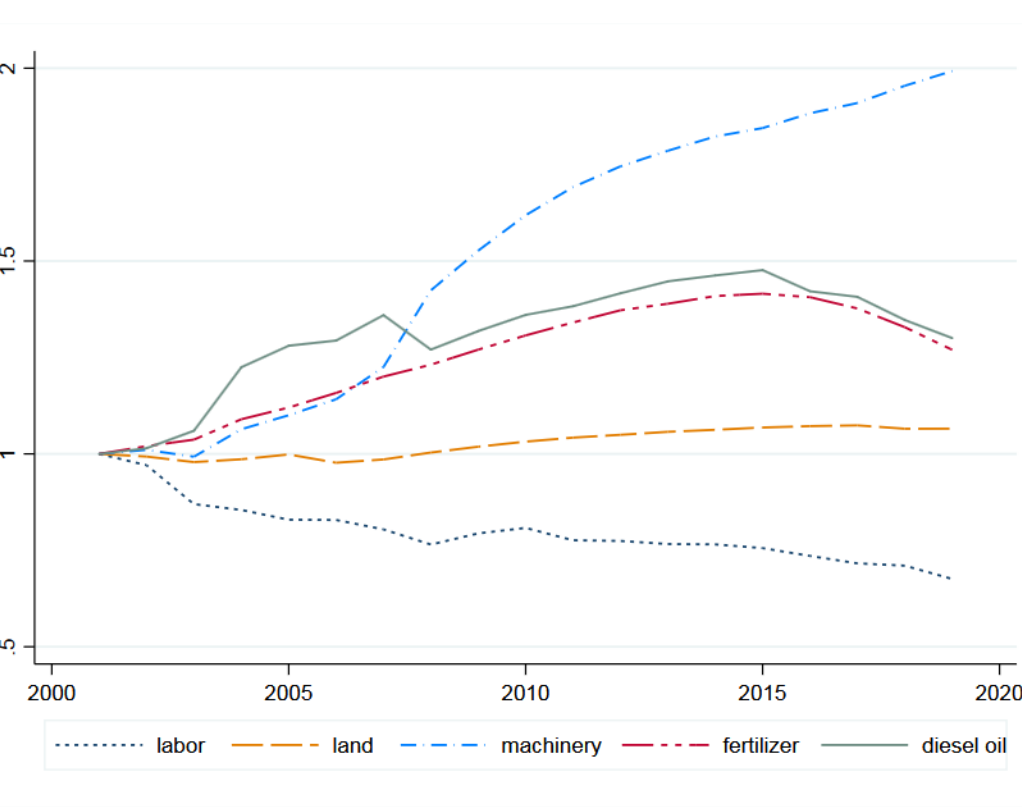
Figure 4. Change rate of planting inputs from 2001 to 2019.